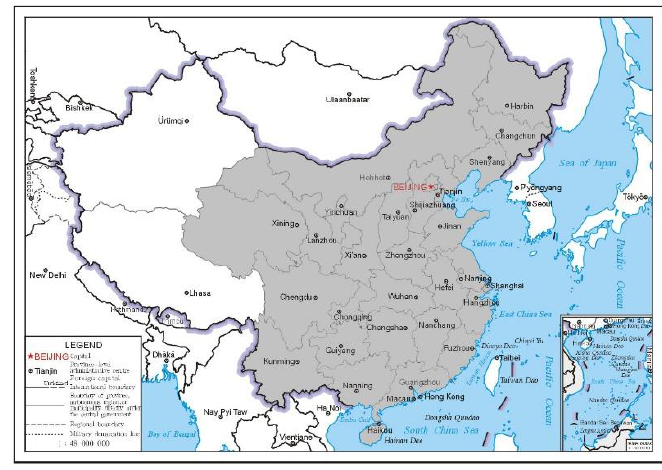
Figure 2. Map of the study area in China 4 .